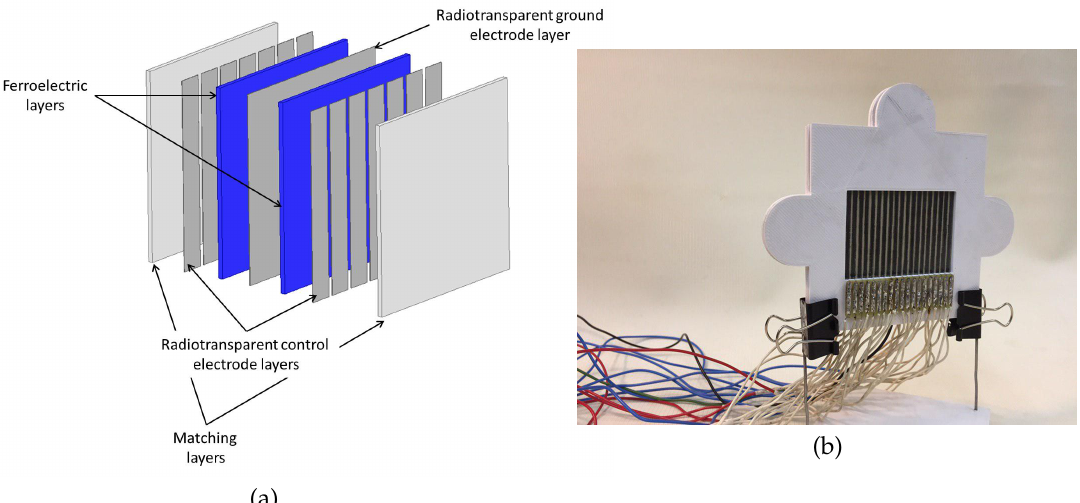
Figure 5. The prototype design: ( a ) Exploded-view of lens prototype without ABS holder structure; ( b ) the photograph of manufactured FE lens without matching